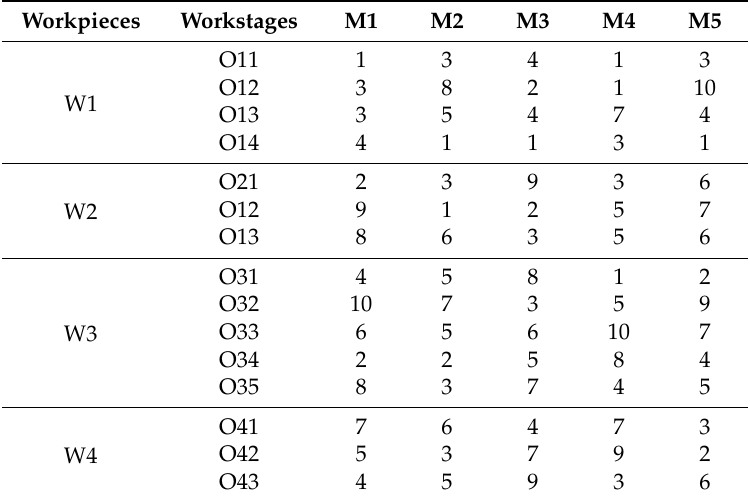
Table 3. List of the Processing Time of Four Workpieces on Five Machines.